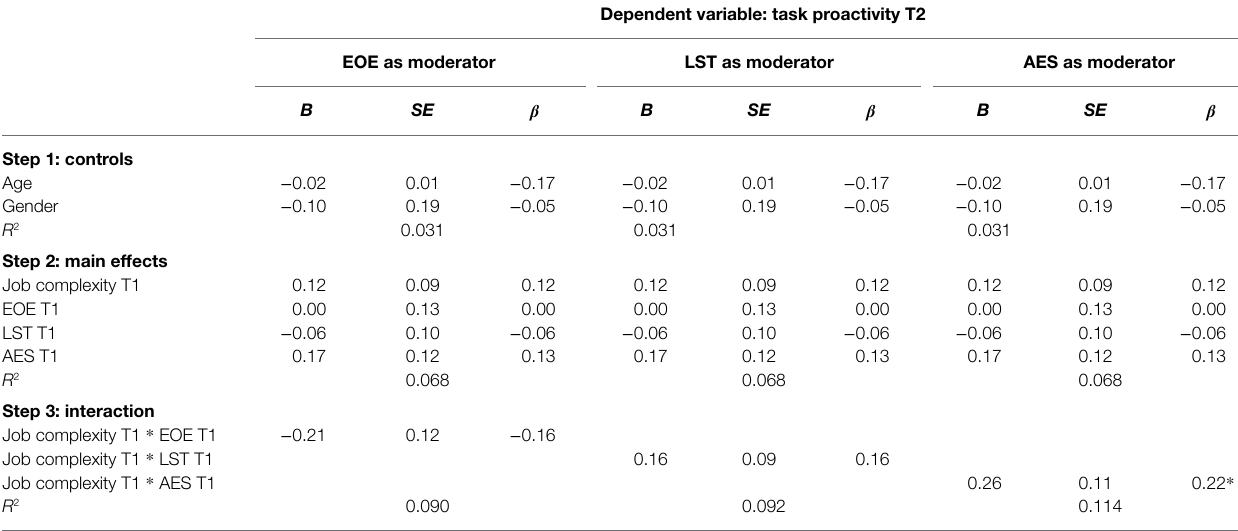
TABLE 5 | Results of hierarchical multiple regression analysis with task proactivity at T2 as Dependent Variable (Study 2).